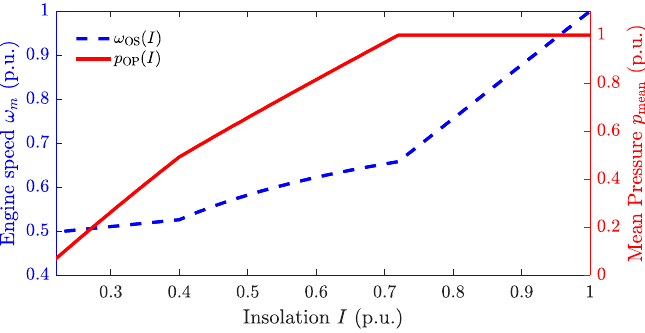
Figure 7. Steady-state p mean vs. I and ω m vs. I relationships.